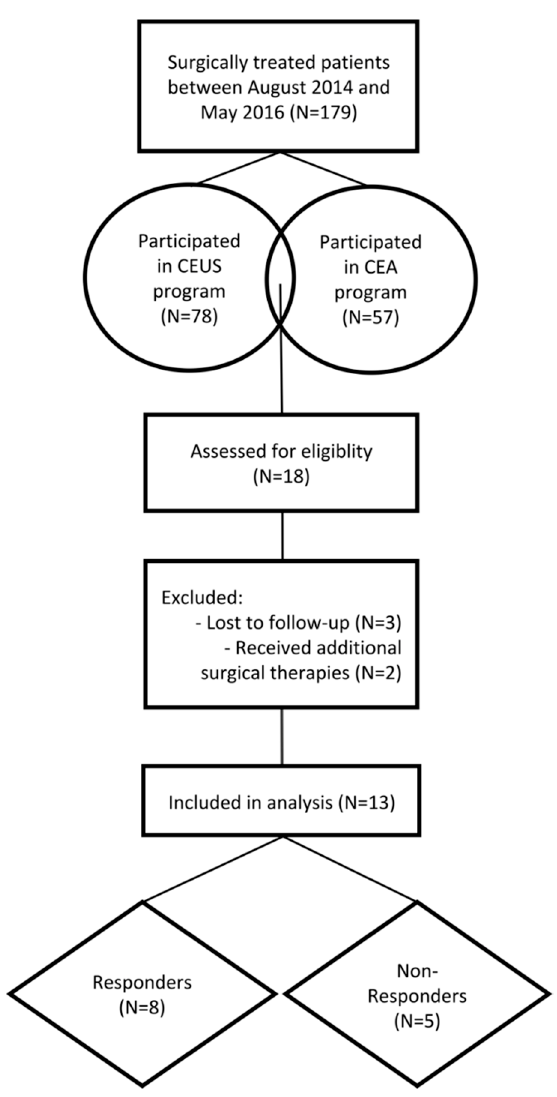
Figure 1. Flow diagram of the patient selection and exclusion process. CEUS, contrast-enhanced ultrasound; CEA, cytokine expression analysis.